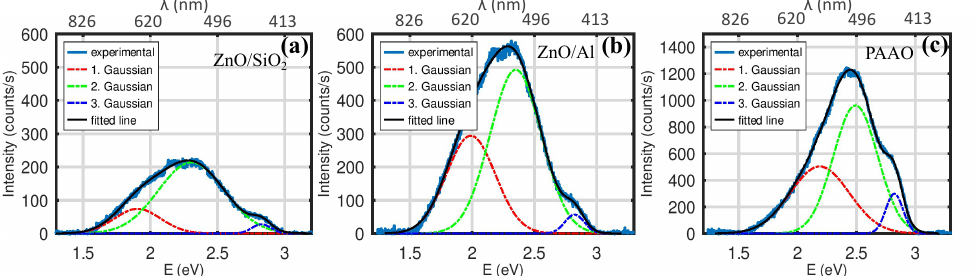
Figure 5. PL spectra of 35 nm ZnO on ( a ) electrochemically polished Al and ( b ) Si wafer. ( c ) PL spectrum of 230 nm PAAO on Al without ZnO.